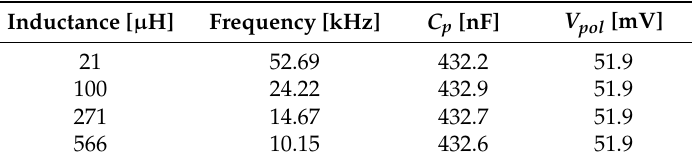
Table 2. Results obtained from simulation using different inductances.